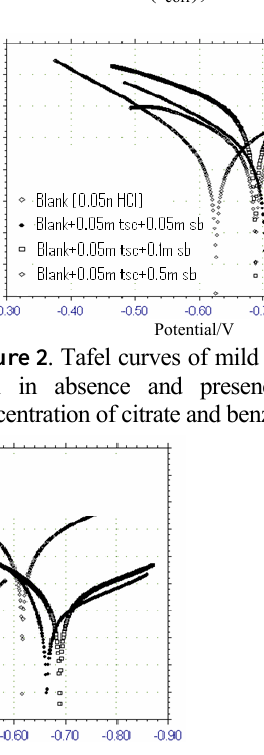
Figure 3. Tafel curves of mild steel in 0.1 N HCl in absence and presence of various concentration of citrate and benzoate